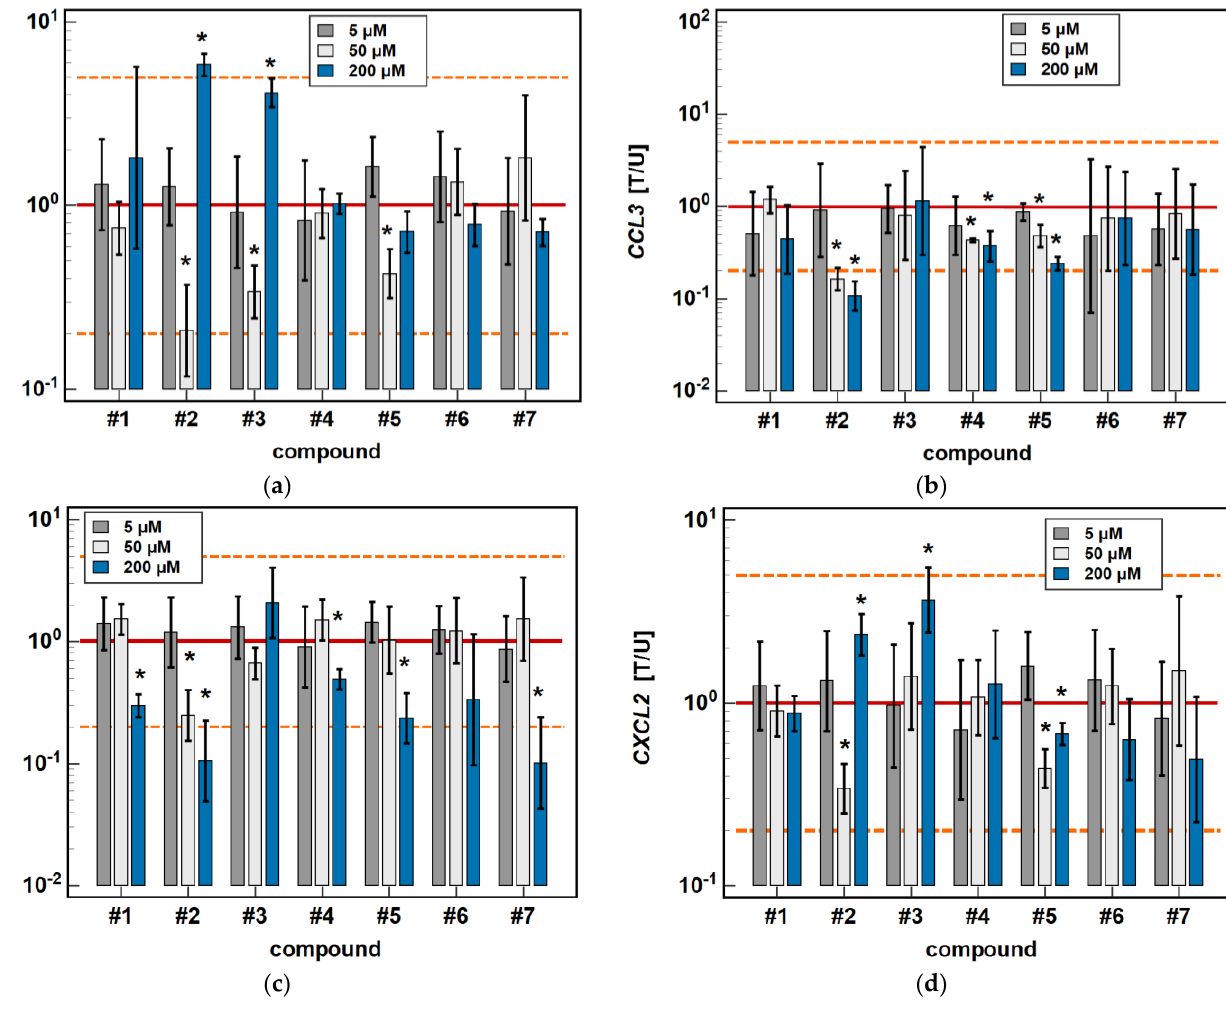
Figure 5. Dose-dependent effect of oxicams on MCP and MIP expression in Caco-2 cells: ( a ) CCL2 ; ( b ) CCL3 ; ( c ) CCL4 ; ( d ) CXCL2 . The bars and whiskers represent the mean ± SD expression ratio of the normalized relative quantities [NRQ] obtained for cells treated with 5, 50, and 200 μM oxicams for 24 h, and the corresponding untreated controls [T/U]. The significant differences between the treated and untreated cells, analyzed using a t -test for paired samples, are indicated by asterisks (*). An expression ratio of 1 (no change) is indicated by a red solid reference line, while an expression ratio of 5 (5-fold upregulation) and an expression ratio of 0.2 (5-fold downregulation) are indicated by an orange dashed reference line. Compound # 6 denotes piroxicam, and # 7 denotes meloxicam.